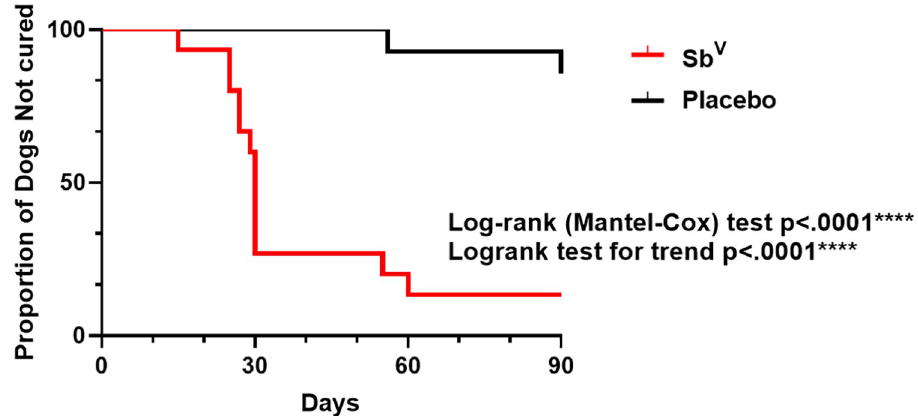
Fig 2. Survival analysis in dogs with CTL. Kaplan-Meier survival analysis of differences in healing time between dogs treated with Glucantime and placebo revealed shorter healing times in dogs treated with Glucantime (P < 0.0001, log- rank